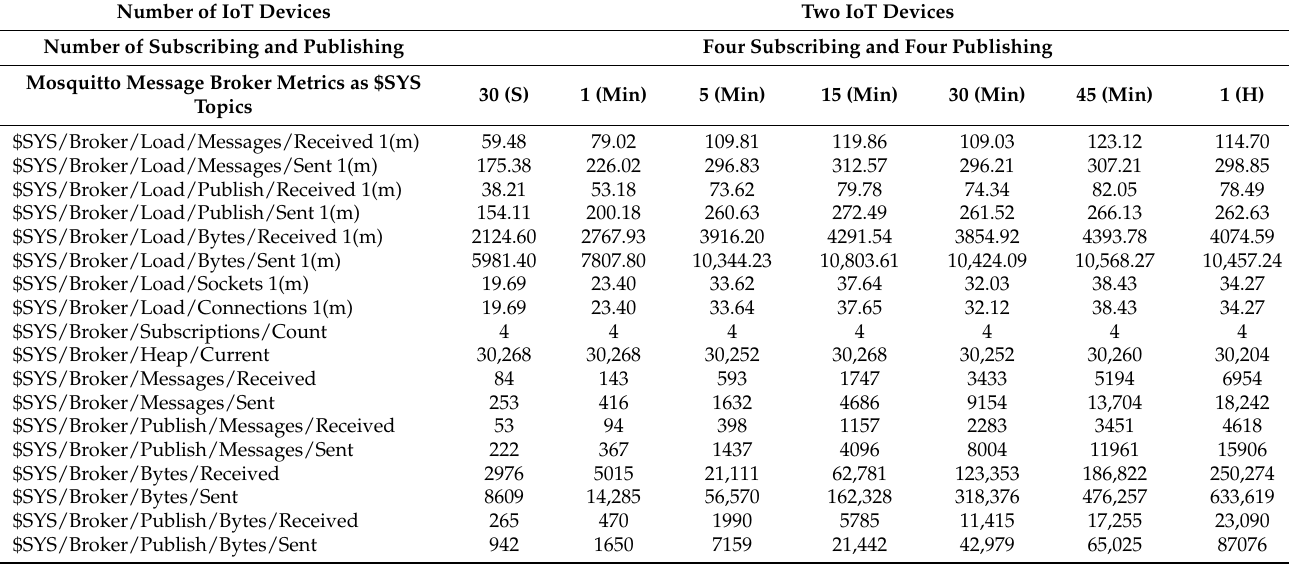
Table 5. Mosquitto message broker metrics on the fog layer using a bridge—first